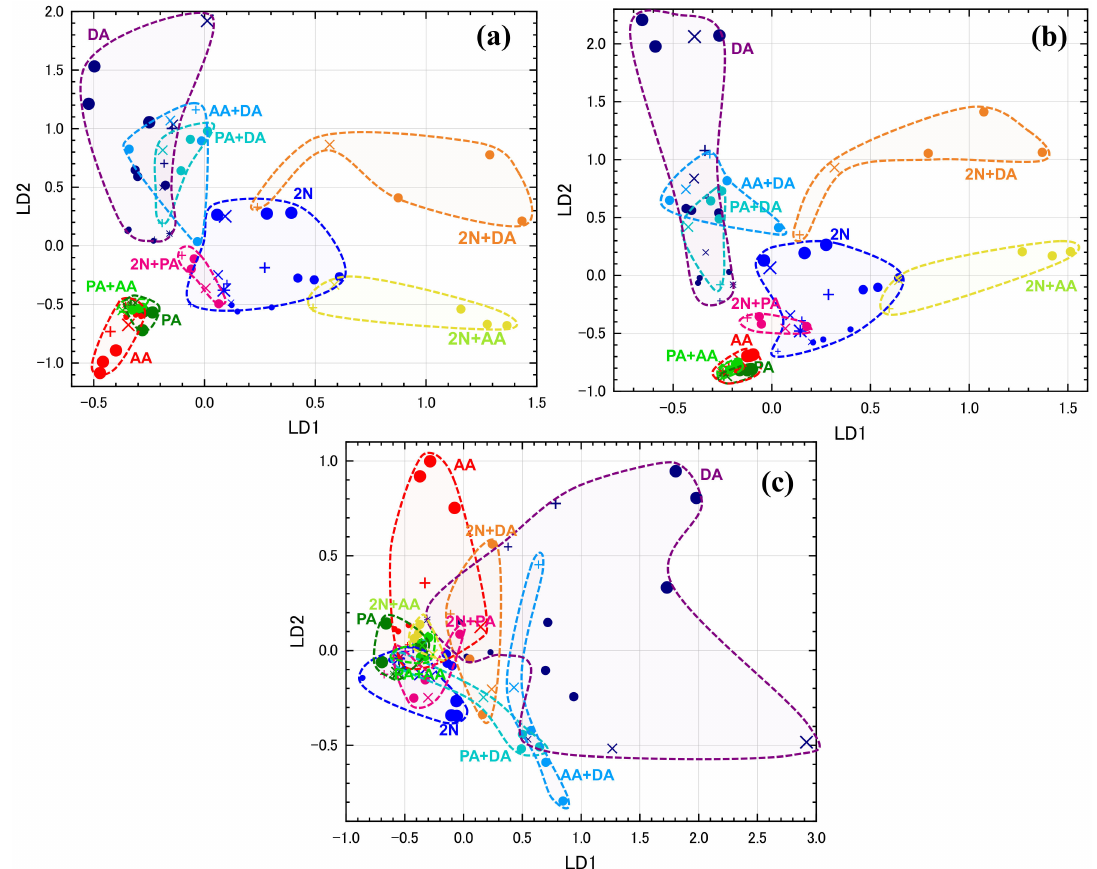
Figure 10. LDA scores from ( a ) four sensors selected by random forest, ( b ) three sensors selected by ReliefF, and ( c ) six sensors: TGS2602, TGS2610, #31b, #33b, No. 9, and No. 71.